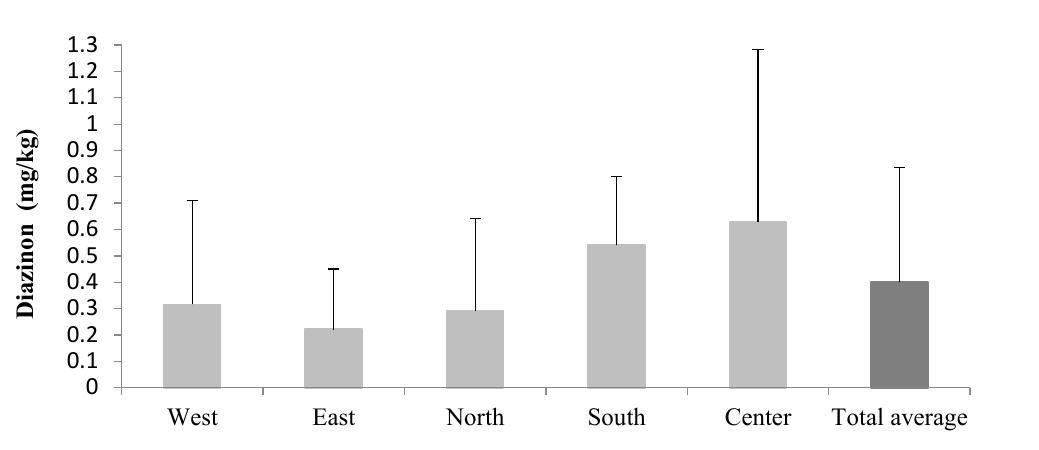
Figure 2. The average and standard deviation for the residual diazinon concentration in each zone of the studied area -